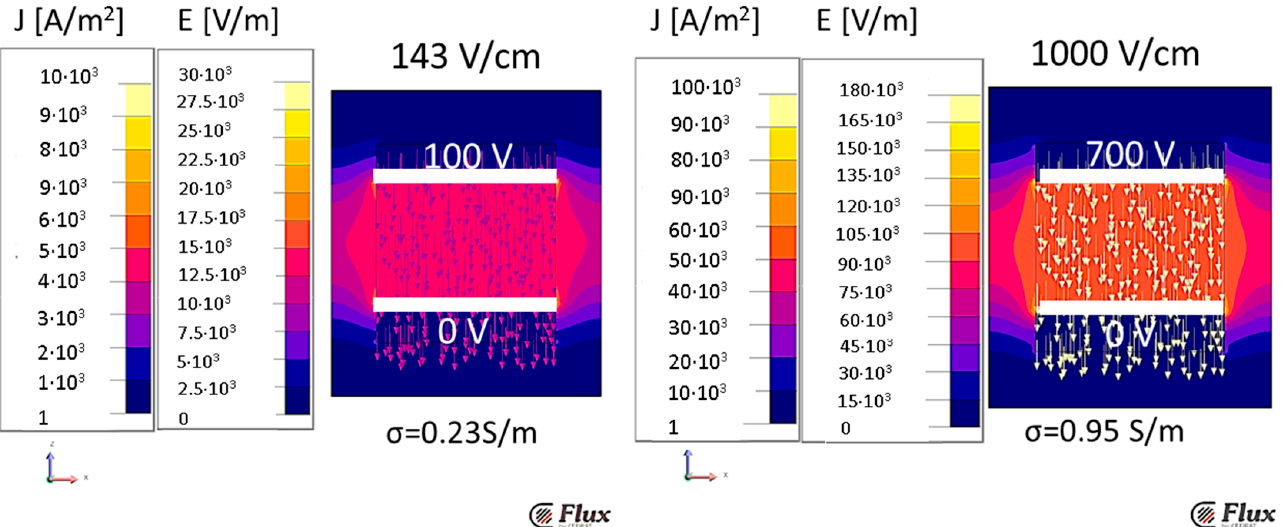
Figure 8. Electric field intensities and current densities in the potato volume and air surrounding in the cubic case when a fixed-conductivity material property is considered-the behavior for the lower (230 mS/m) ( left ) and for the higher (950 mS/m) ( right ).